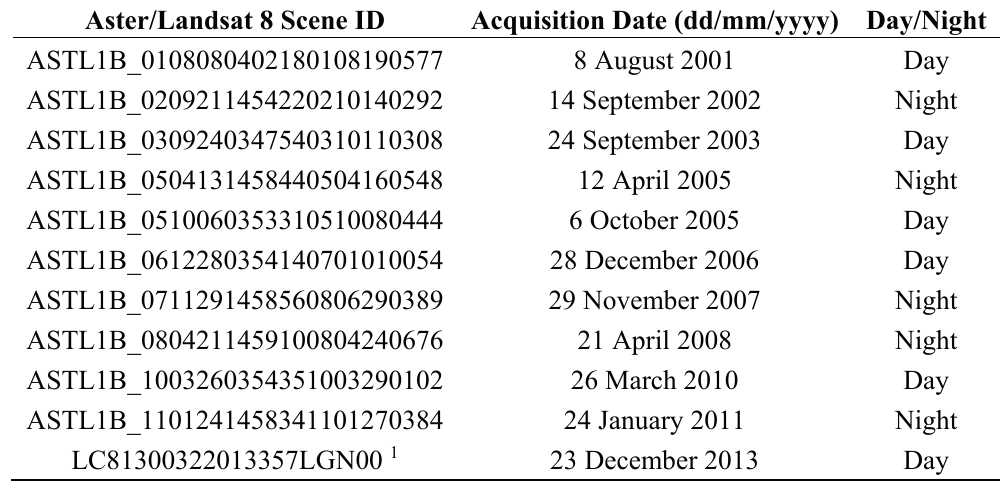
Table 5. Information on the ASTER/Landsat 8 data used in coal fire long-term